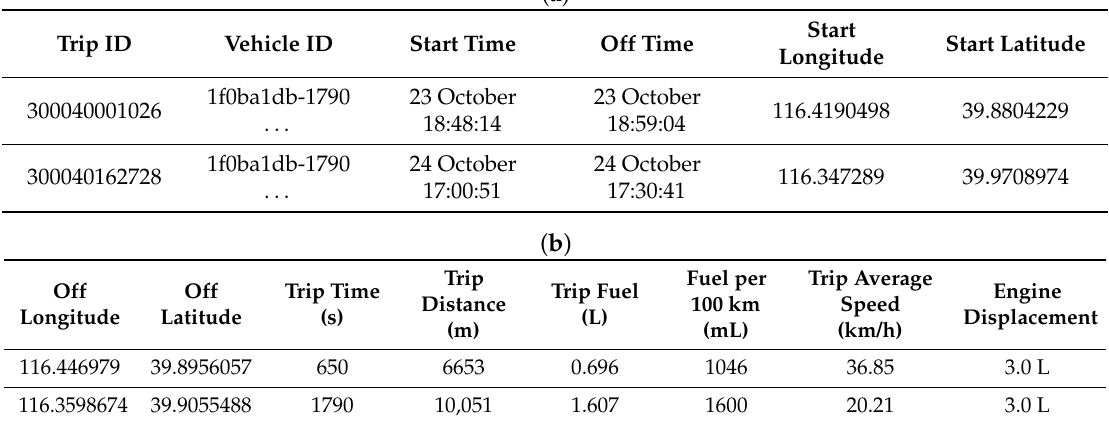
Table 2. The sample of the trip data.